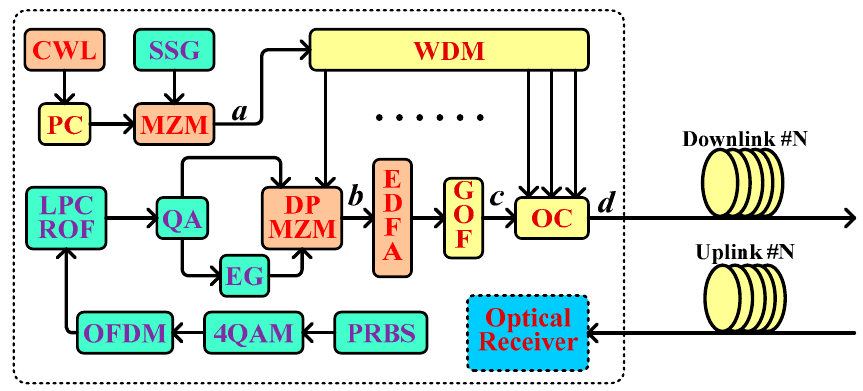
Figure 2. Function block diagram of the central station (CS).